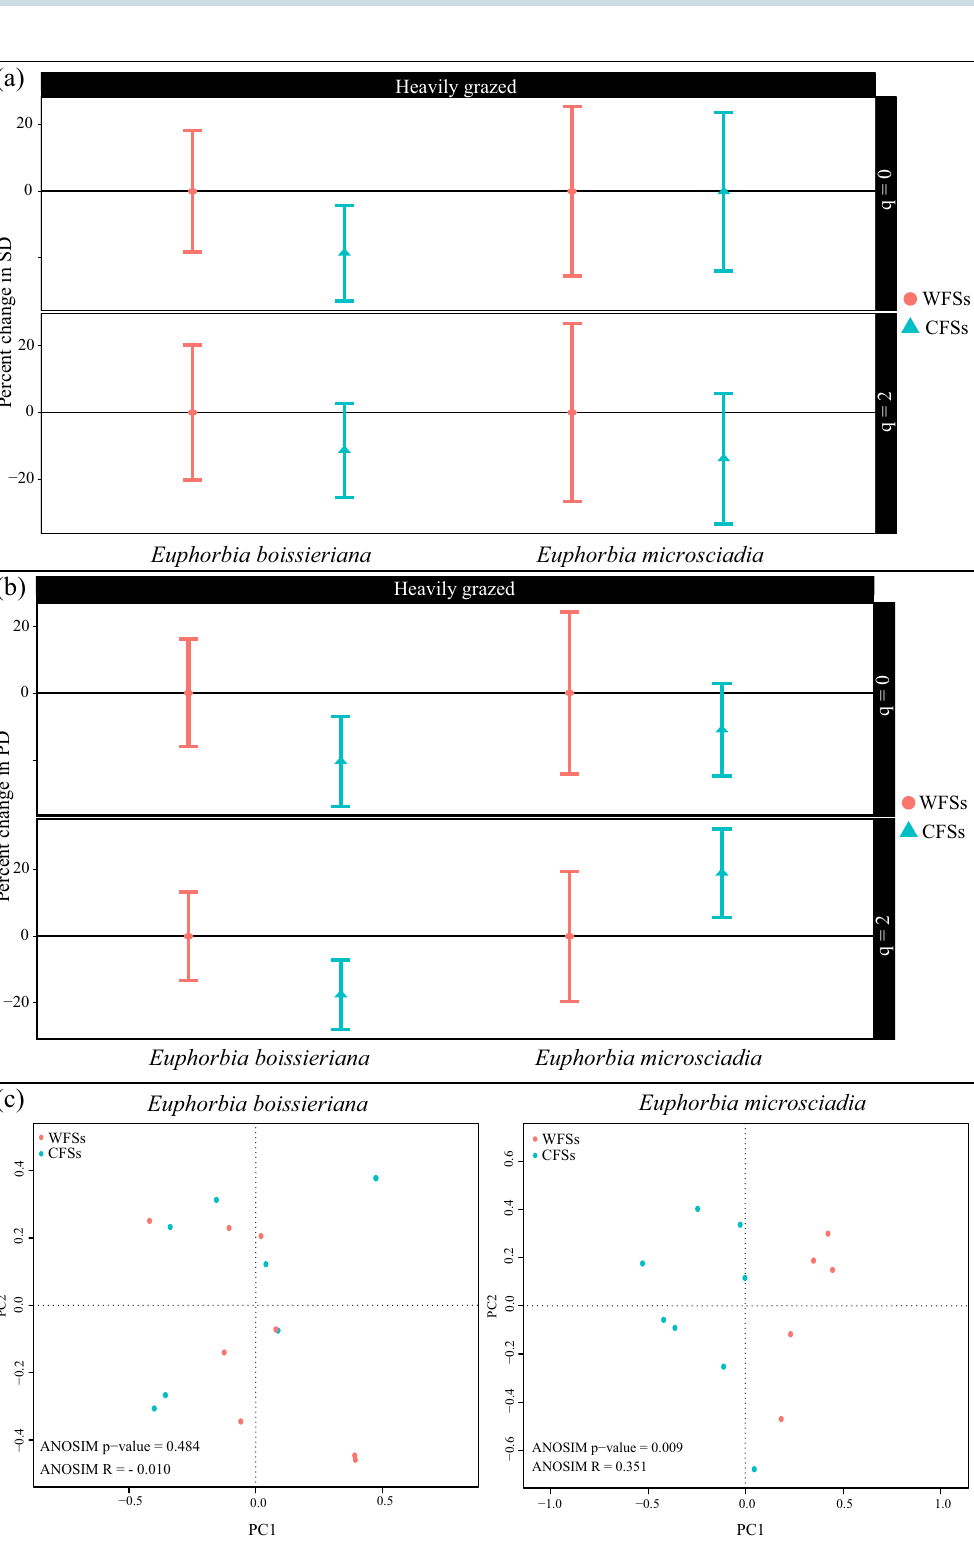
Figure 4. The coverage-based comparison of ( a ) species and ( b ) phylogenetic diversity of communities containing (CFSs) and without (WFSs) Euphorbia boissieriana and Euphorbia microsciadia . ( c ) Transformation- based principal component analysis and analysis of similarity (ANOSIM) results showing the species composition differences in CFSs and